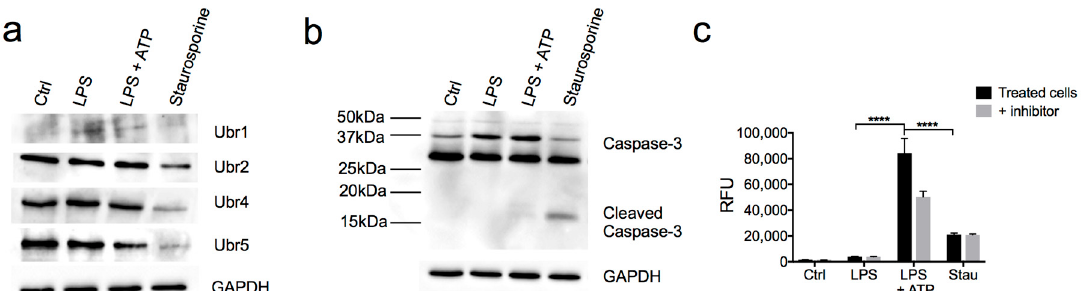
Figure 5. N-recognins of the Arg / N-degron were not degraded during inflammation. ( a ) Western blot analysis of UBR-ub ligases of the Arg / N-degron pathway after caspase-1 or caspase-3 activation. Cells were treated with LPS (100 ng / mL) or staurosporine (500 nM) for 24 h and assessed for the 4 UBR ub-ligases, for caspase-3 ( b ), and for caspase-1 activity ( c ). Caspase-1 activity was measured in the media of cells treated as in ( a ) in presence of the caspase-1-specific inhibitor Ac-YVAD-CHO in half of the wells. P -values were determined by a one-way ANOVA (**** p < 0.0001).